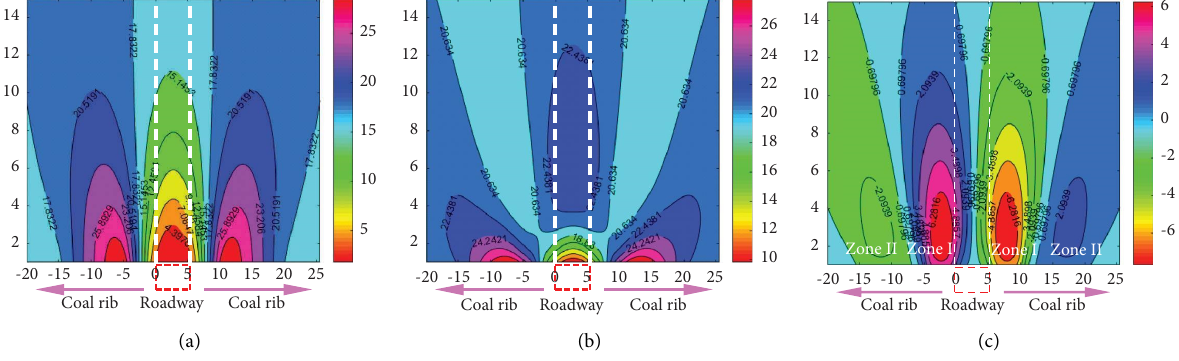
Figure 6: Stress cloud of roof: (a) vertical stress; (b) horizontal stress; (c) shear